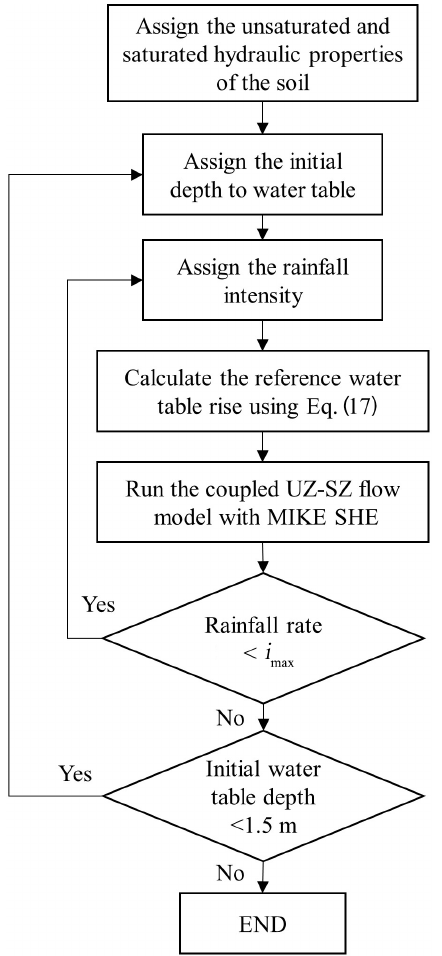
Figure 4. Step-by-step procedure of the WTF method used in MIKE SHE. i max is the minimum of saturated hydraulic conductivity of the four soil types. ψ 1 is the soil bubbling pressure given in Table